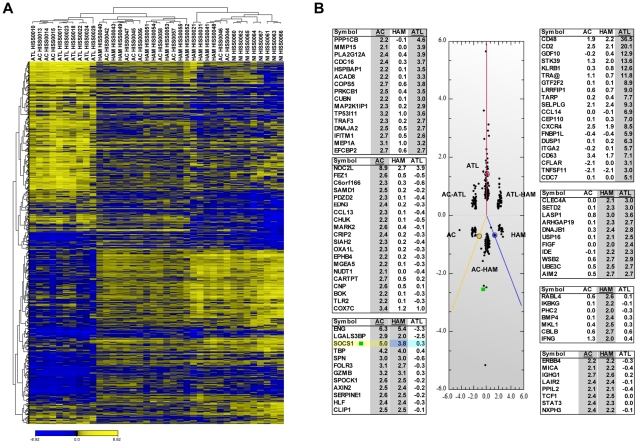
Expression profiling of genes differentially expressed in HTLV-1 associated-diseases.(A) Unsupervised hierarchical clustering of the 1039 genes differentially expressed in CD4+ T lymphocytes from 7 ATL, 12 HAM/TSP, 11 AC and 8 NI donors. Significant variation in the expression pattern of 1039 genes was determined by ANOVA (p<0.01). Each row represents the relative level of expression for a single gene; each column shows the expression level for a single sample. The yellow and blue colors indicate high and low expression, respectively. Genes were clustered into 3 groups using a complete linkage and Pearson correlation as distance metric. (B) Pair-wise contrast by Correspondance Analysis (PCA). PCA analysis was performed on the 1039 genes selected by ANOVA. Correspondence analysis shows genes plotted in discriminate space and separated into 6 groups: genes associated specifically with ATL, HAM/TSP or AC, and genes commonly regulated in the three groups; AC-HAM/TSP, AC-ATL or ATL-HAM/TSP. Colored lines denote the direction of class medians and black dots correspond to the genes. Genes with high differential expression in a group are located far-off the center (gene expression of NI), in the direction determined by the group. The closest to the group line, the more evident is the associations of the genes with that group. Genes that are down-regulated in this group appear on the opposite site of the centroid. A short list of the top genes was created by selecting the genes having ≥2 fold changes relative to NI. The genes lists are ranked by the absolute variation (Max-Min) in fold change expression among the three HTLV-1 infected groups.